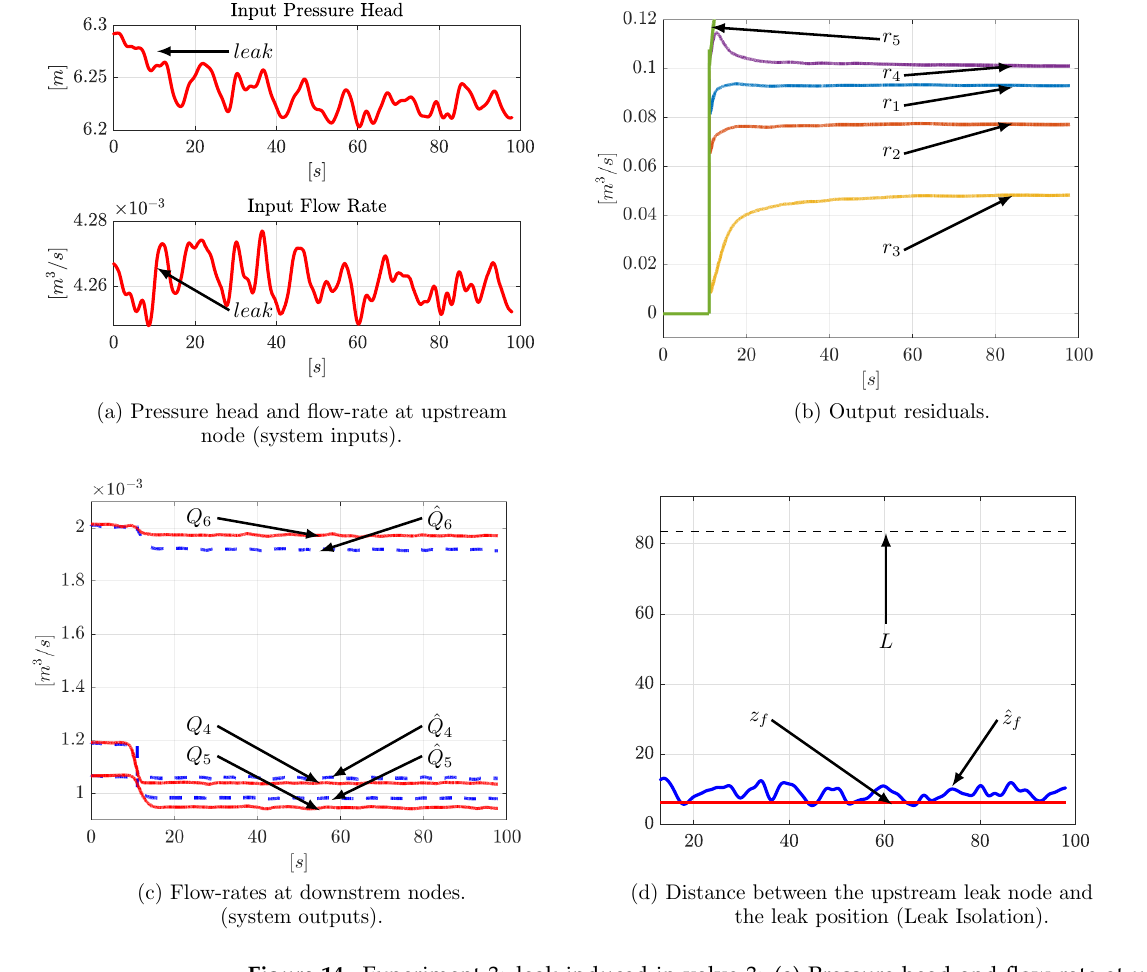
Figure 14. Experiment 3: leak induced in valve 3: ( a ) Pressure head and flow rate at upstream, ( b ) Output residuals, ( c ) Flow rate at downstream nodes and, ( d ) Leak